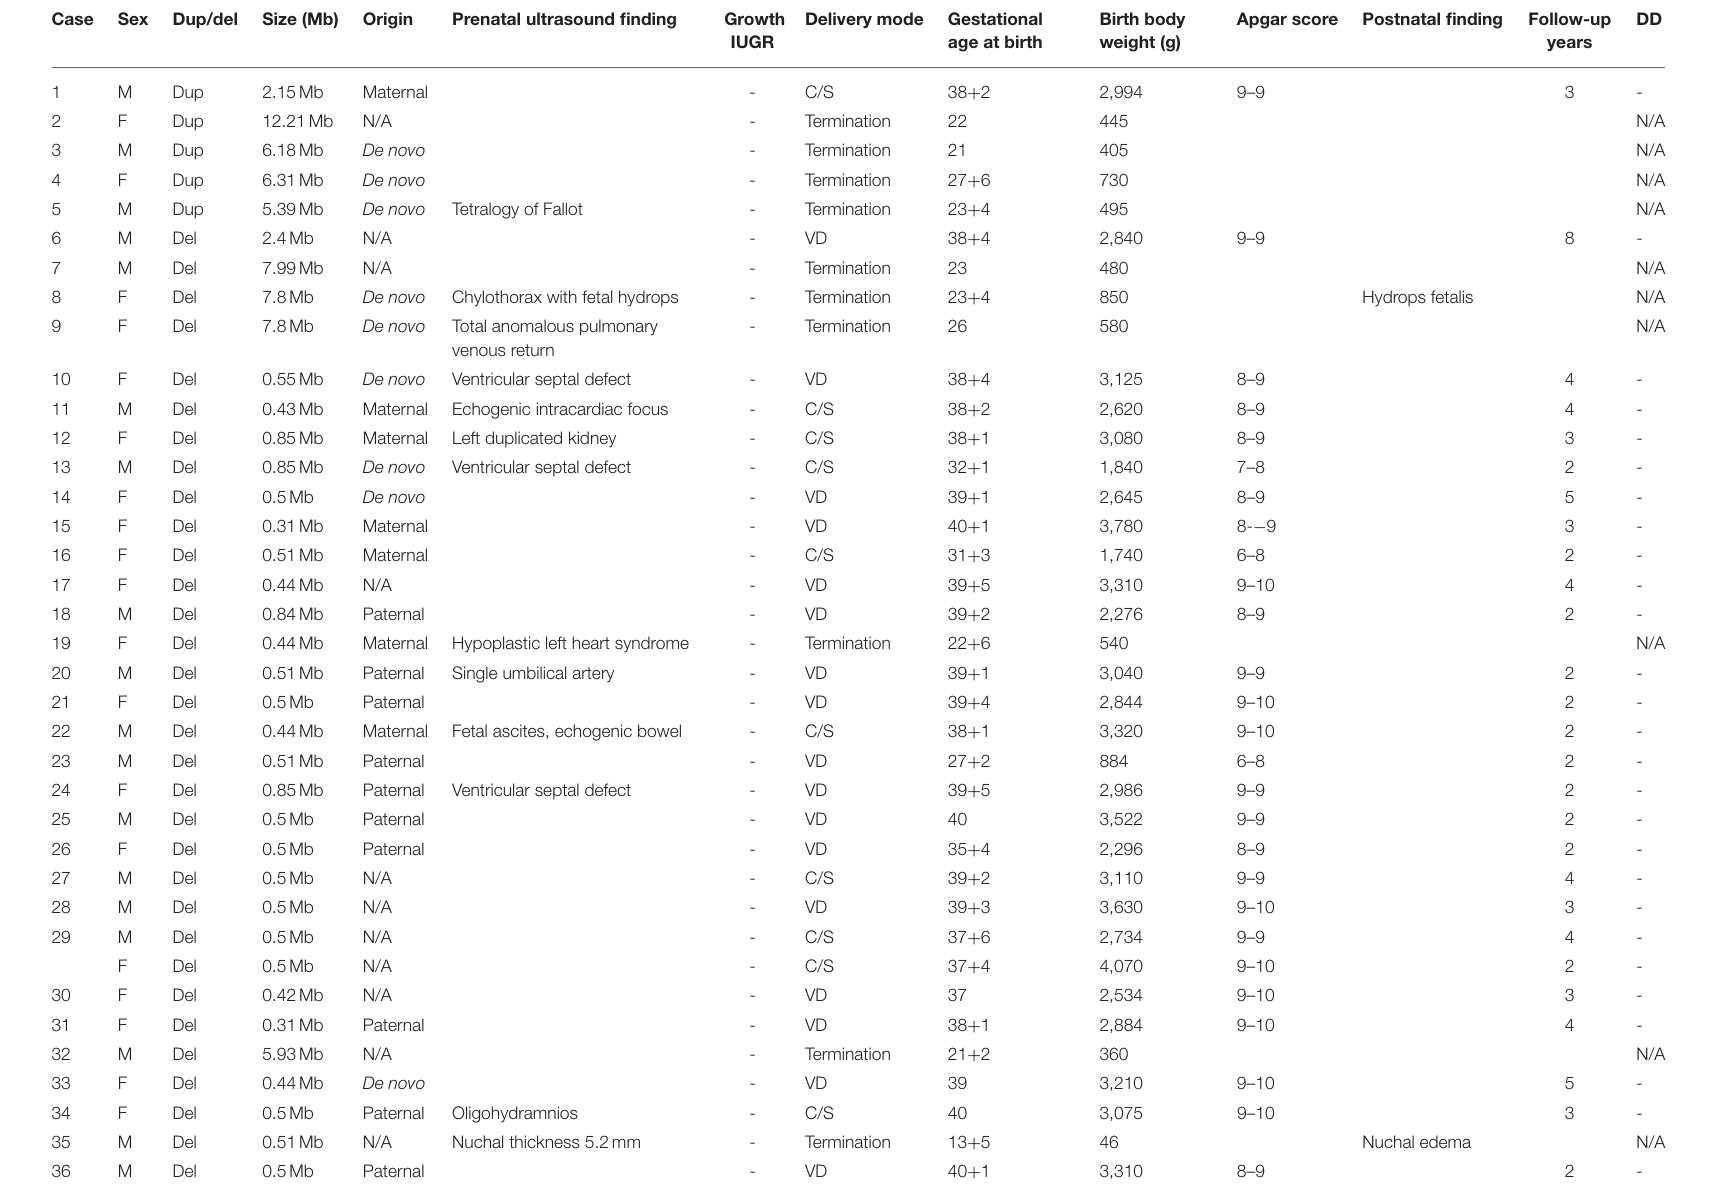
TABLE 1 | The findings of fetuses with 15q11.2 copy number variant (CNV) and newborn